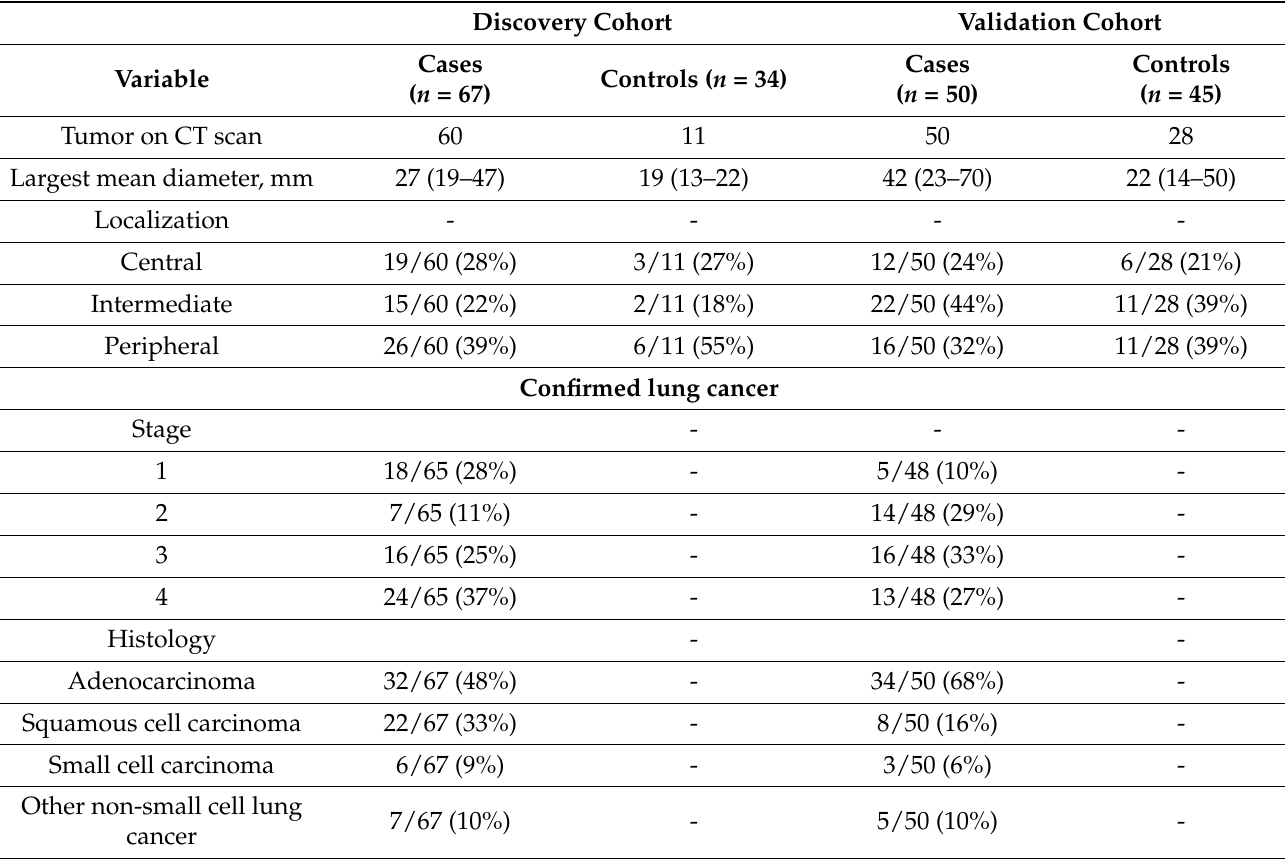
Table 2. Tumor characteristics for the Discovery and Validation cohorts, respectively, separated into columns for cases and controls. Stage and histology are only reported for cases. Continuous variables are reported as median (interquartile range, IQR), and categorical variables are reported as fraction (percentage, %). As a result of rounding, not all categories add up to